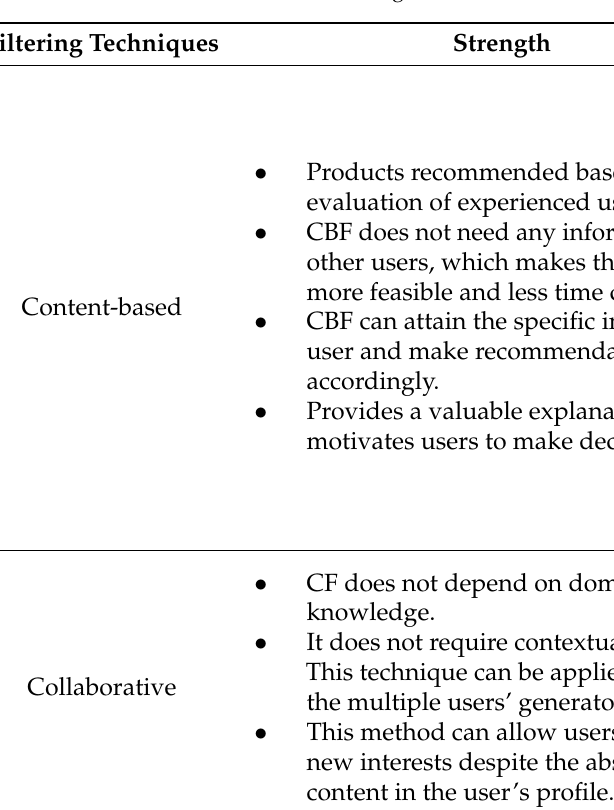
Table 4. Strengths and weakness of recommendation filtering